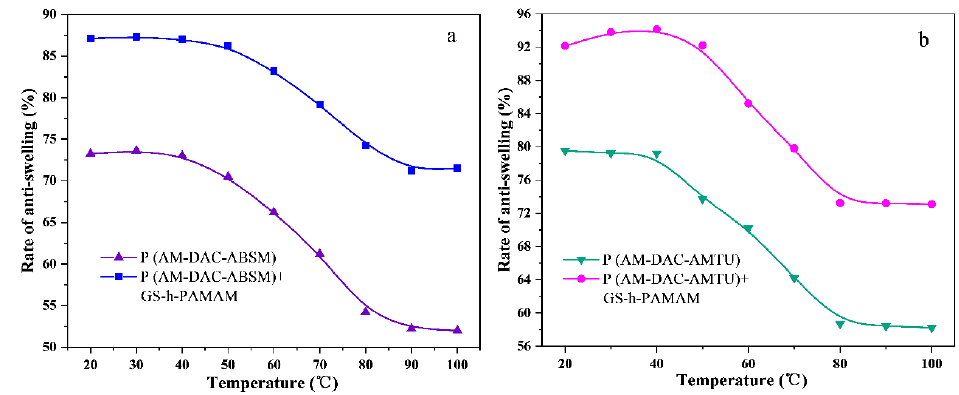
E ff ect of temperature on the rate of anti-swelling: ( a ) P(AM-DAC-ABSM) and its Figure 7. Effect of temperature on the rate of anti-swelling: (a) P(AM-DAC-ABSM) and its supramolecular system; ( b ) P(AM-DAC-AMTU) and its supramolecular supramolecular system; (b) P(AM-DAC-AMTU) and its supramolecular system.